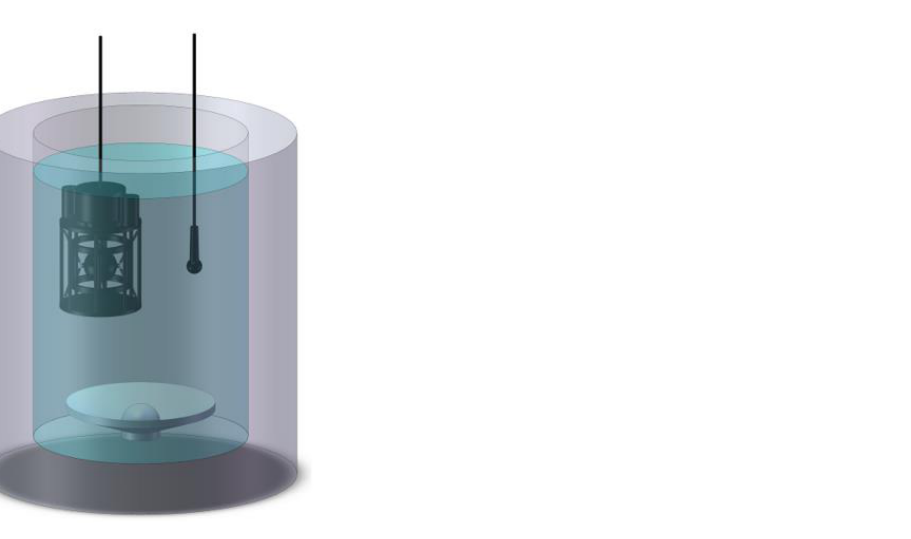
Figure 15. The experimental setup for testing the acceleration responses of the FOVH in the two suspension systems.